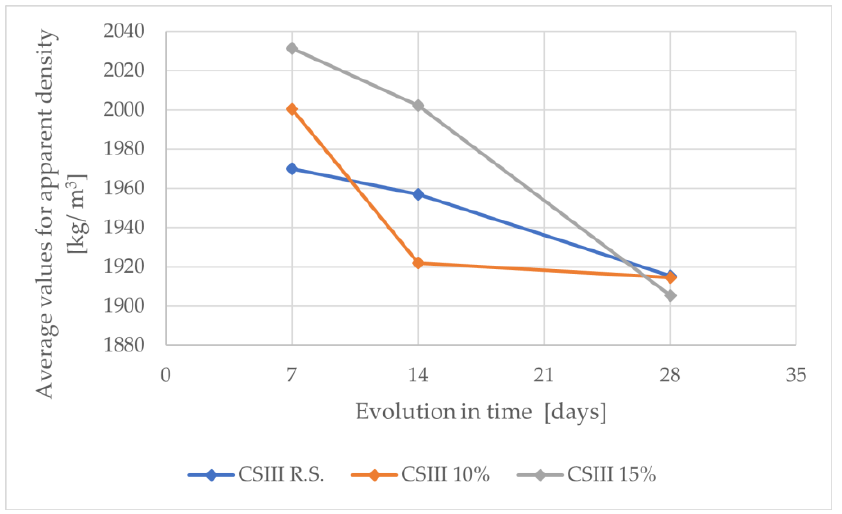
Figure 14. Apparent density in the hardened state.